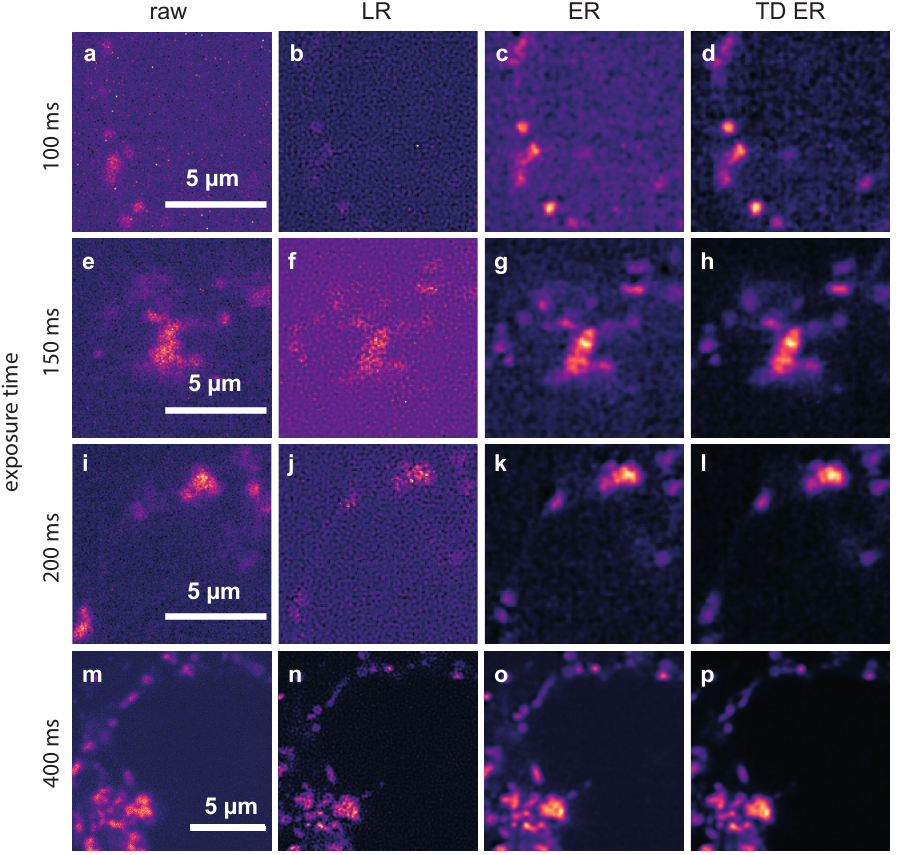
Figure 3. Comparison of the different deconvolution methods for TPC2-R.GECO.1.2 images captured with different exposure times. ( a , e , i , m ): raw data, captured at 100 ms, 150 ms, 200 ms and 400 ms; ( b , f , j , n ): images deconvolved using MATLAB’s Lucy–Richardson (LR) algorithm; ( c , g , k , o ): images deconvolved using the static entropy algorithm (ER); ( d , h , l , p ): images deconvolved with the time- dependent entropy algorithm (TD ER). Parameters for the entropy algorithms are λ = 2.0 and (TD ER: λ = 2.0, λ T = 2.0) and ε =